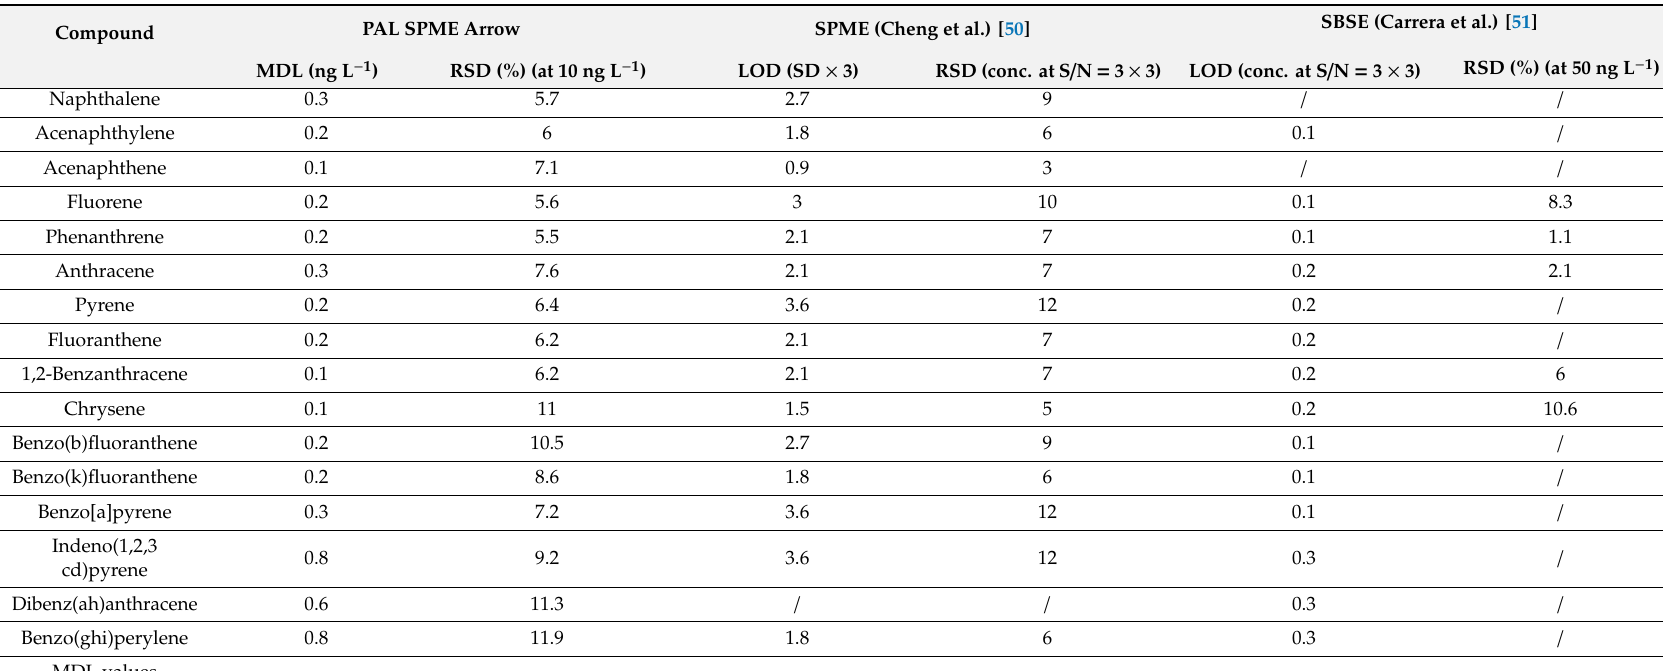
Table 5. Comparison of SPME, SPME Arrow and stir bar sorbtive extraction (SBSE) for determination of polycyclic aromatic hydrocarbons (PAHs) in water via direct immersion. MDL and RSD results were obtained with PAL SPME Arrow (250 µ m × 20 mm, 10.2 µ L) for PAHs in water in comparison with literature data for classical SPME fibers and SBSE bars. Table reprinted from Reference [48] (open